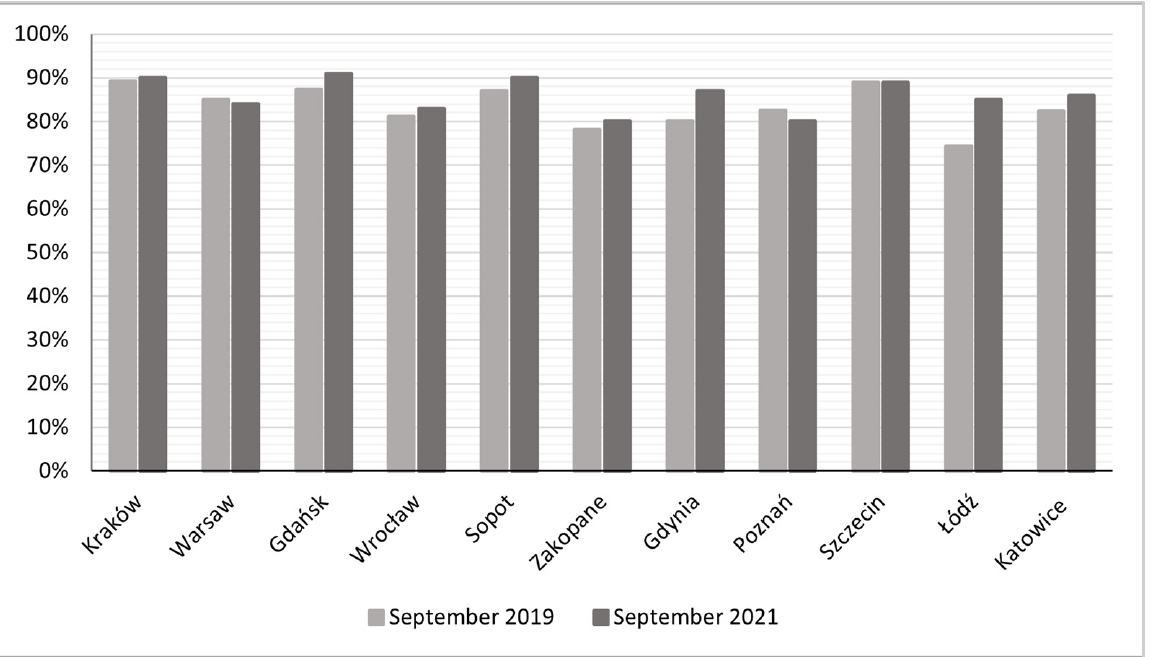
Figure 9. Share of entire home rentals in the total Airbnb and Vrbo offer.